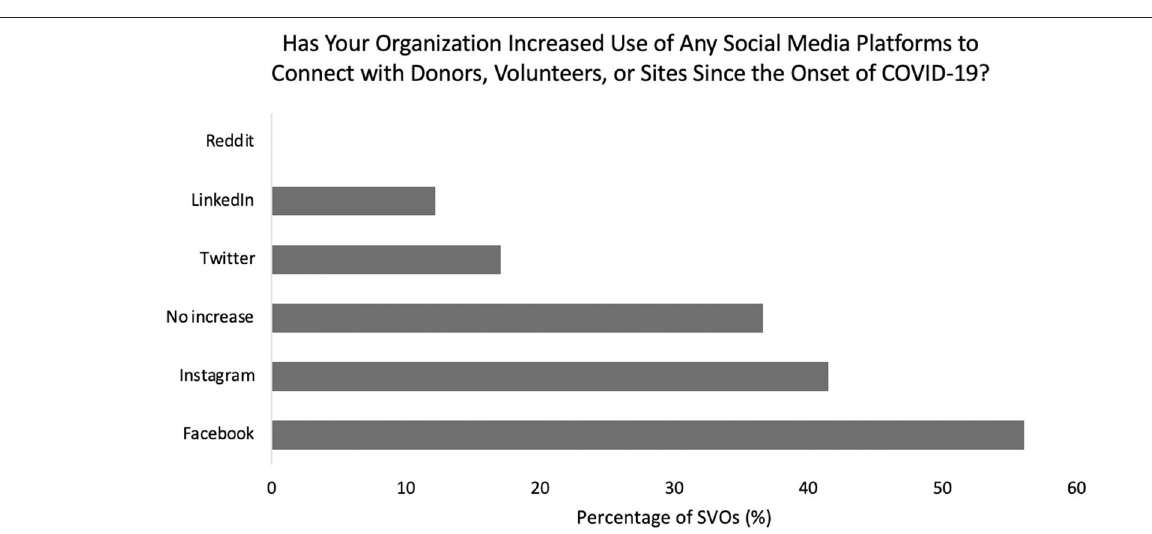
FIGURE 8 | Breakdown of social media platform utilization by surgical volunteer organizations during the